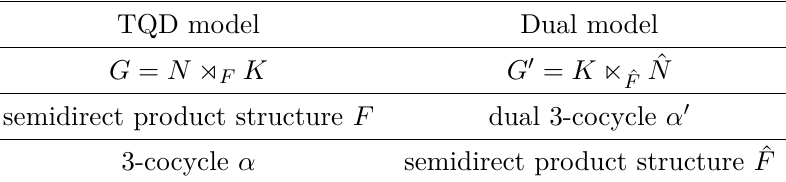
Table 2 . The mapping of the key structures under the